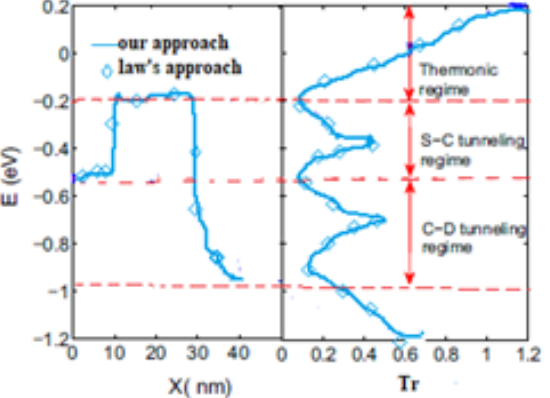
Figure 7. GFET potential profile and corresponding transmission spectra of GFET; proposed method (solid line), and proposed approach (circles).